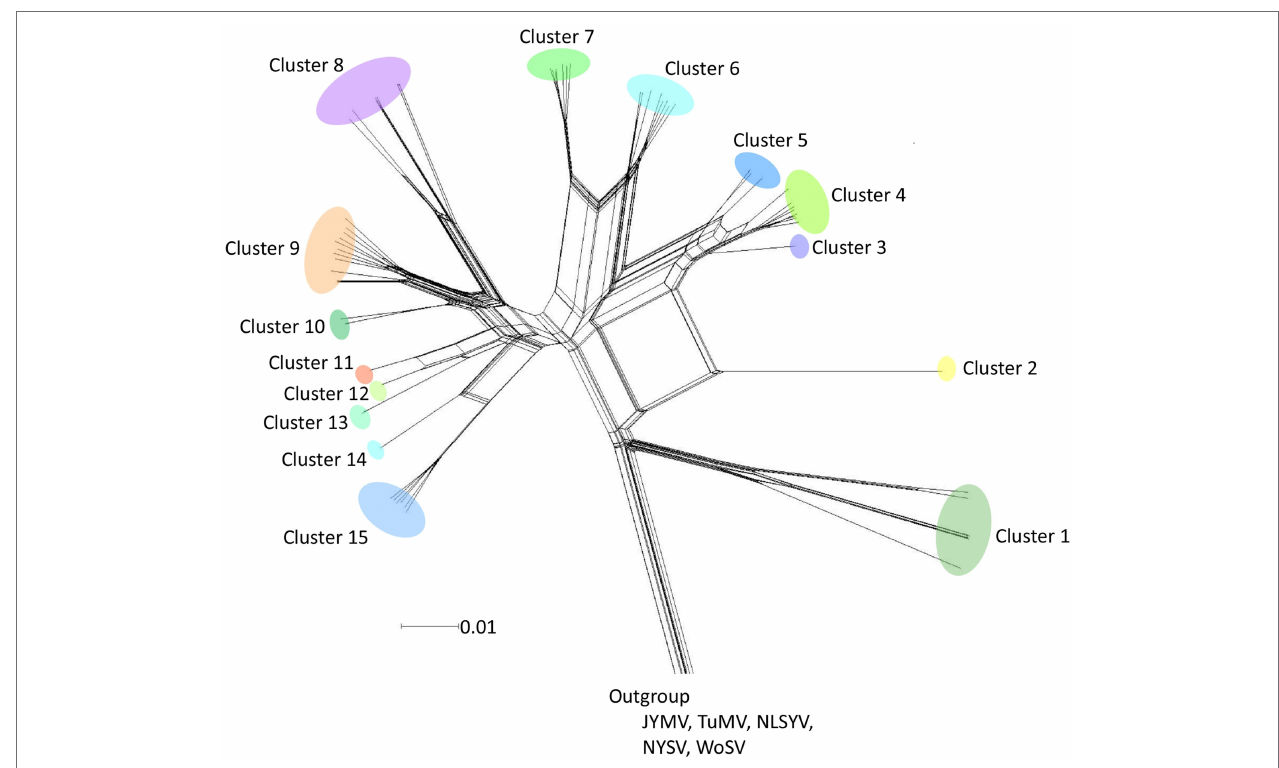
FIGURE 2 | Split-decomposition phylogenetic networks. Neighbor-Net tree inferred from polyprotein-coding sequences of 64 scallion mosaic virus (ScaMV) isolates. Three sequences of Japanese yam mosaic virus (JYMV; Fuji and Nakamae, 1999, 2000; Lan et al., 2015), two turnip mosaic virus (TuMV; Nguyen et al., 2013), three narcissus late season yellows virus (NLSYV), three narcissus yellow stripe virus (NYSV;Chen et al., 2006; Lin et al., 2012; Wylie et al., 2014; Ohshima et al., 2018), and one wild onion symptomless virus (WoSV; Ohshima et al., 2016a) were used as outgroup taxa. The scale bar indicates genetic